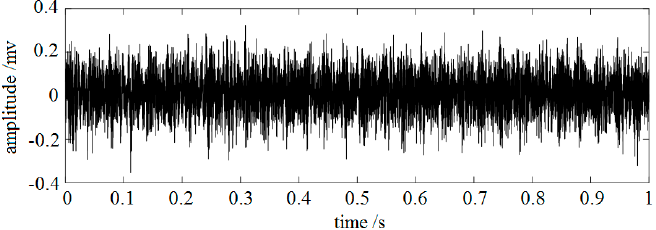
Figure 2. An example of normal bearing condition monitoring (CM) signal.